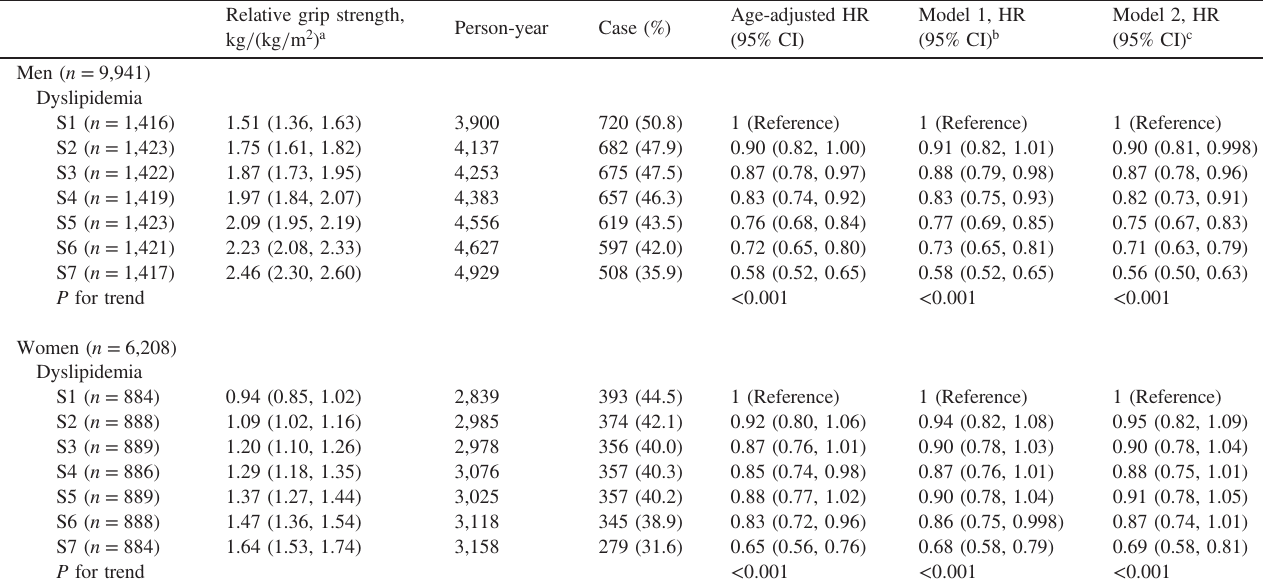
Table 2. Hazard ratios of the incidence of dyslipidemia according to septiles of relative grip strength among men and women Relative grip strength, kg = (kg = m 2 ) a